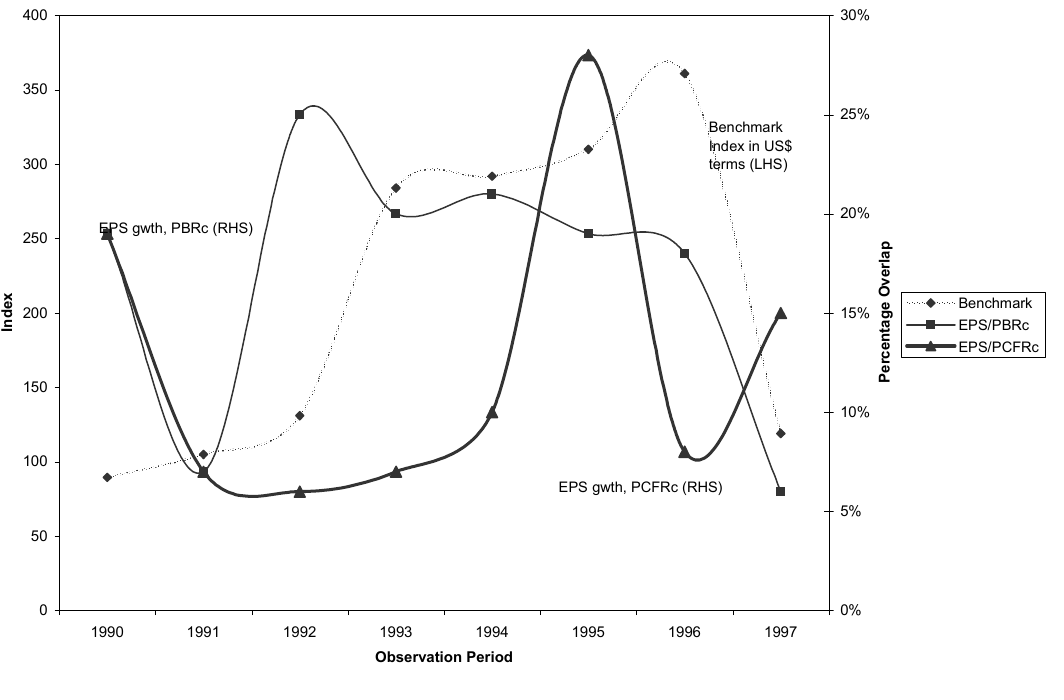
Fig. 2: Overlap (Q1) of EPS Growth with PBRc and